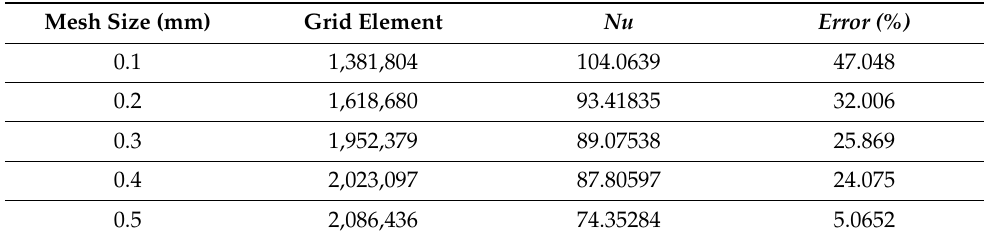
Table 3. Grid-independent testing with different mesh sizes.